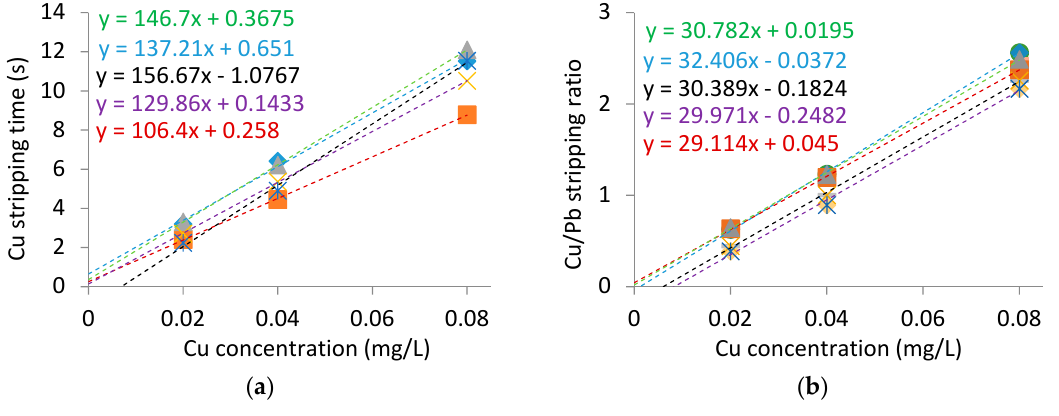
Figure 2. Cu calibration graphs in model wine: ( a ) utilizing copper stripping time; ( b ) utilizing the Cu stripping time normalized to the Pb stripping time.